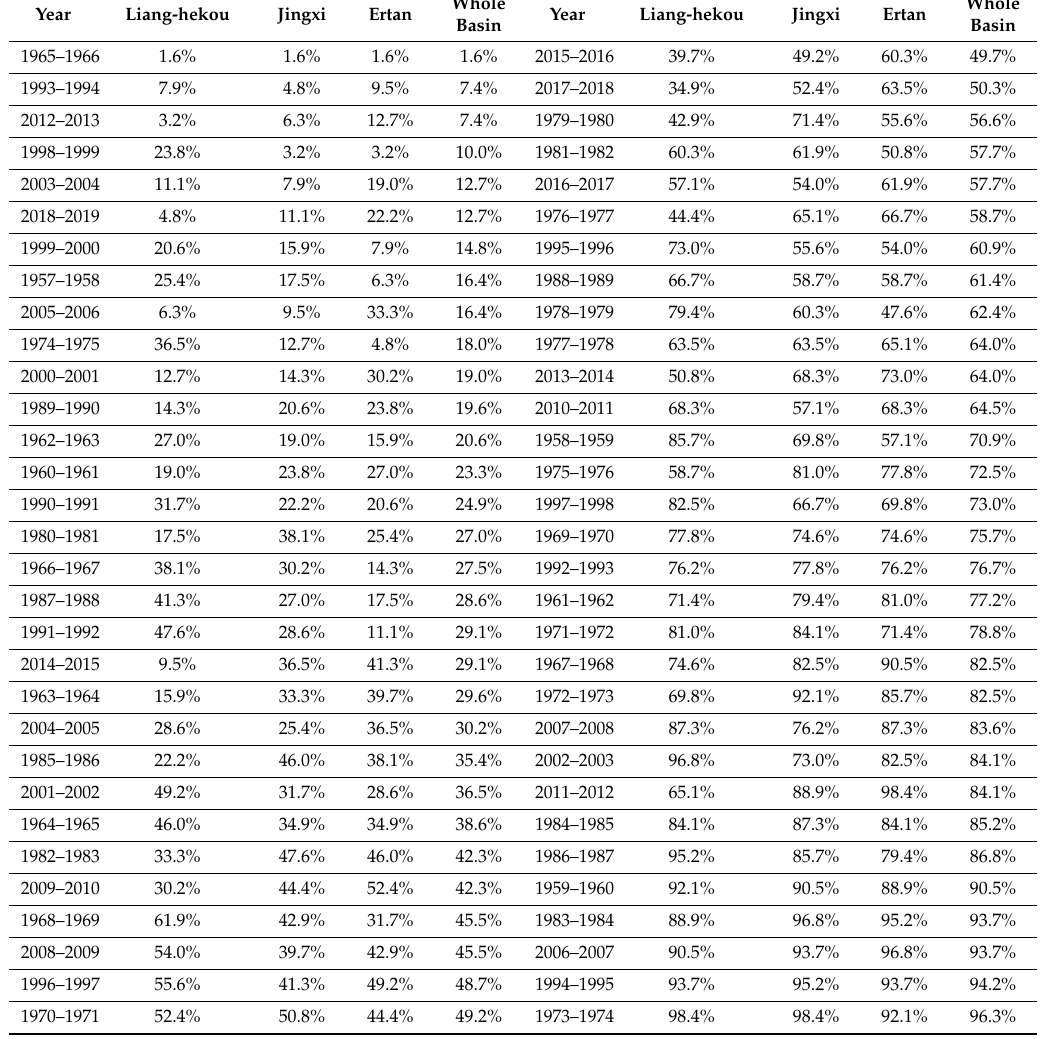
Table 3. Inflow frequency of each station and the whole basin in each hydrological